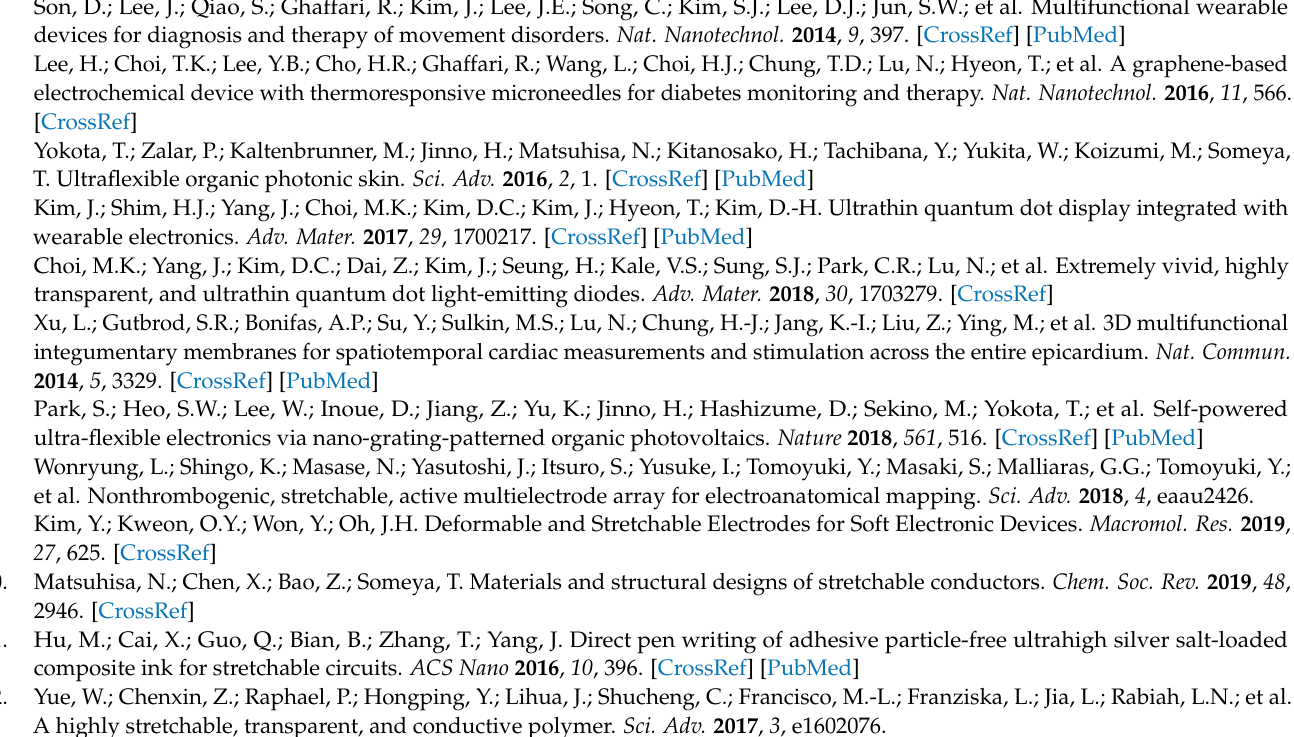
Figure S2: XPS Data of the surface treated-PDMS substrates, Figure S3: Images and contact angles of static droplets on pristine and surface treated PDMS substrate, Figure S4: FEM Simulation results of the stress distribution of conventional mesh structure and the BSS mesh structure under 30% strain, Figure S5: Optical microscopy images of the stretchable electrode stretched up to 70% tensile strain, Figure S6: FE-SEM Images of microstructured PDMS substrates before spray coating and after peeling off the stretchable